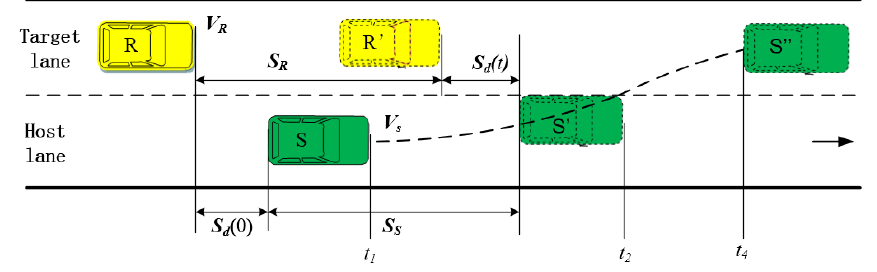
Figure 6. Lane change behavior.